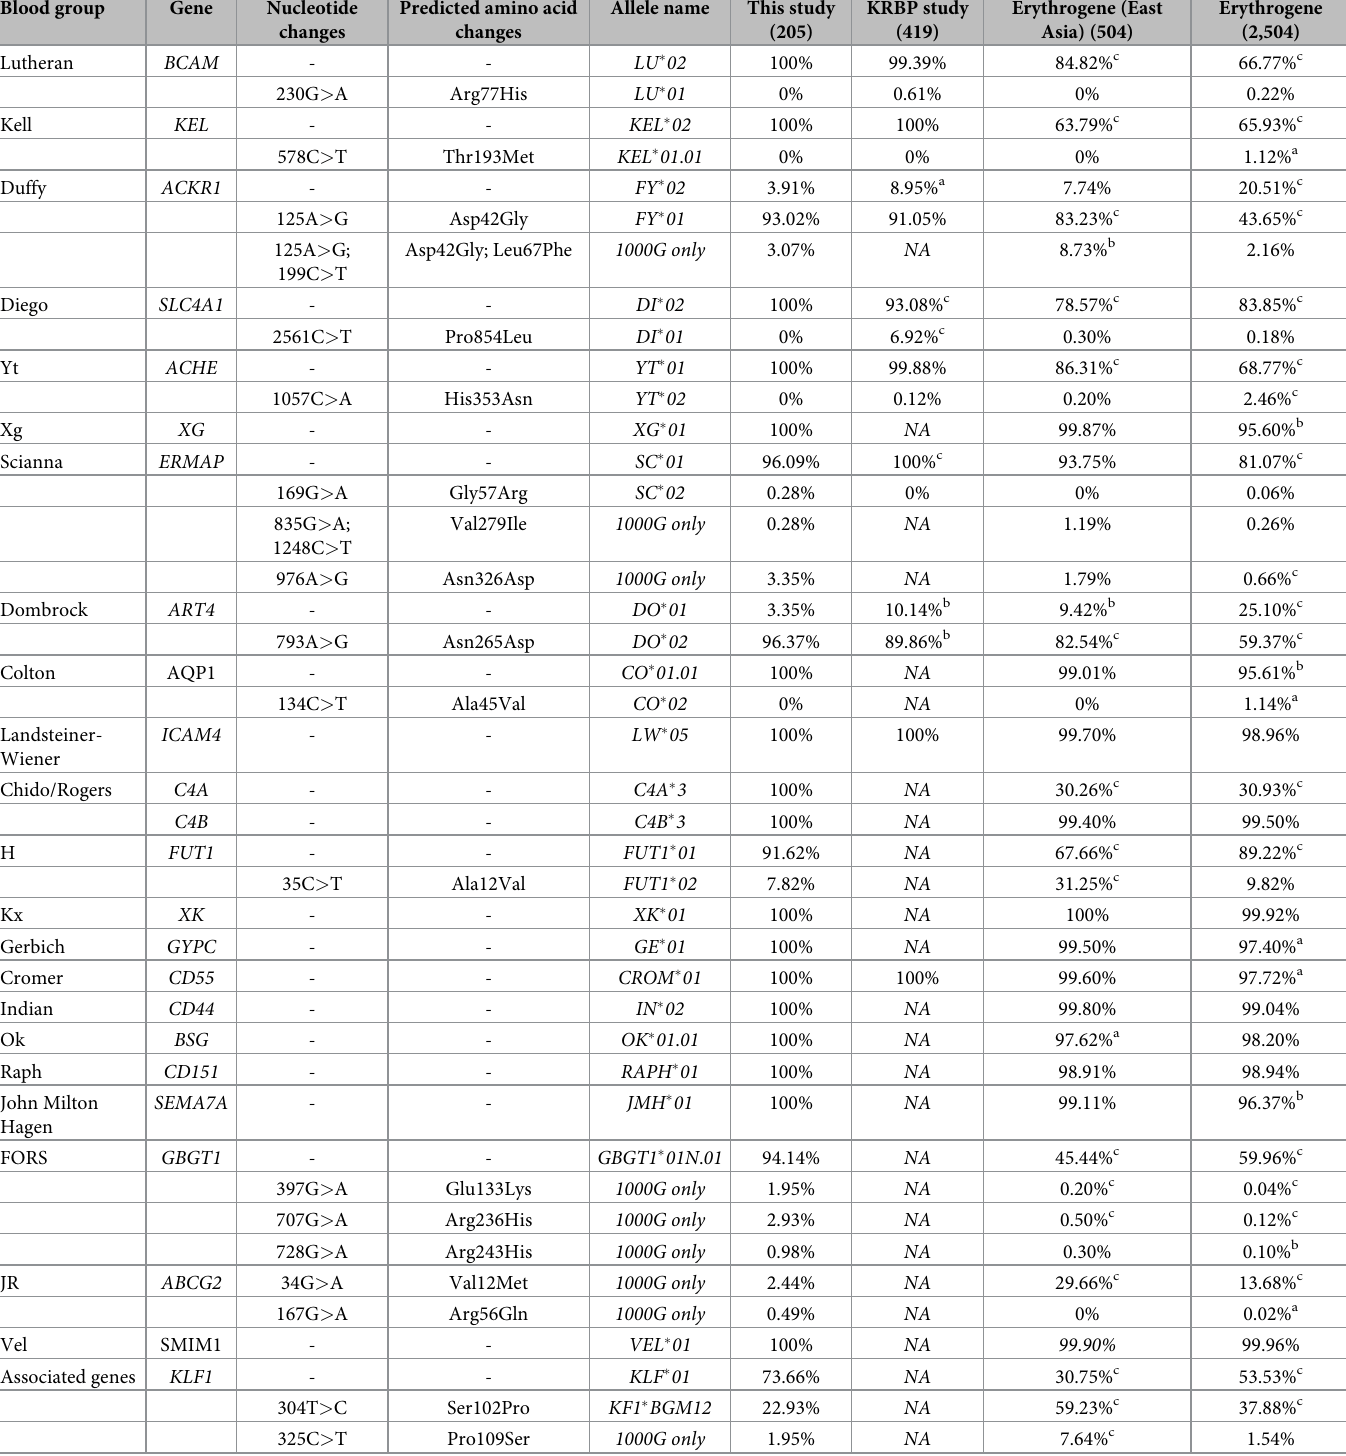
Table 3. Comparison of allele frequencies between this study, KRBP and Erythrogene data. Blood